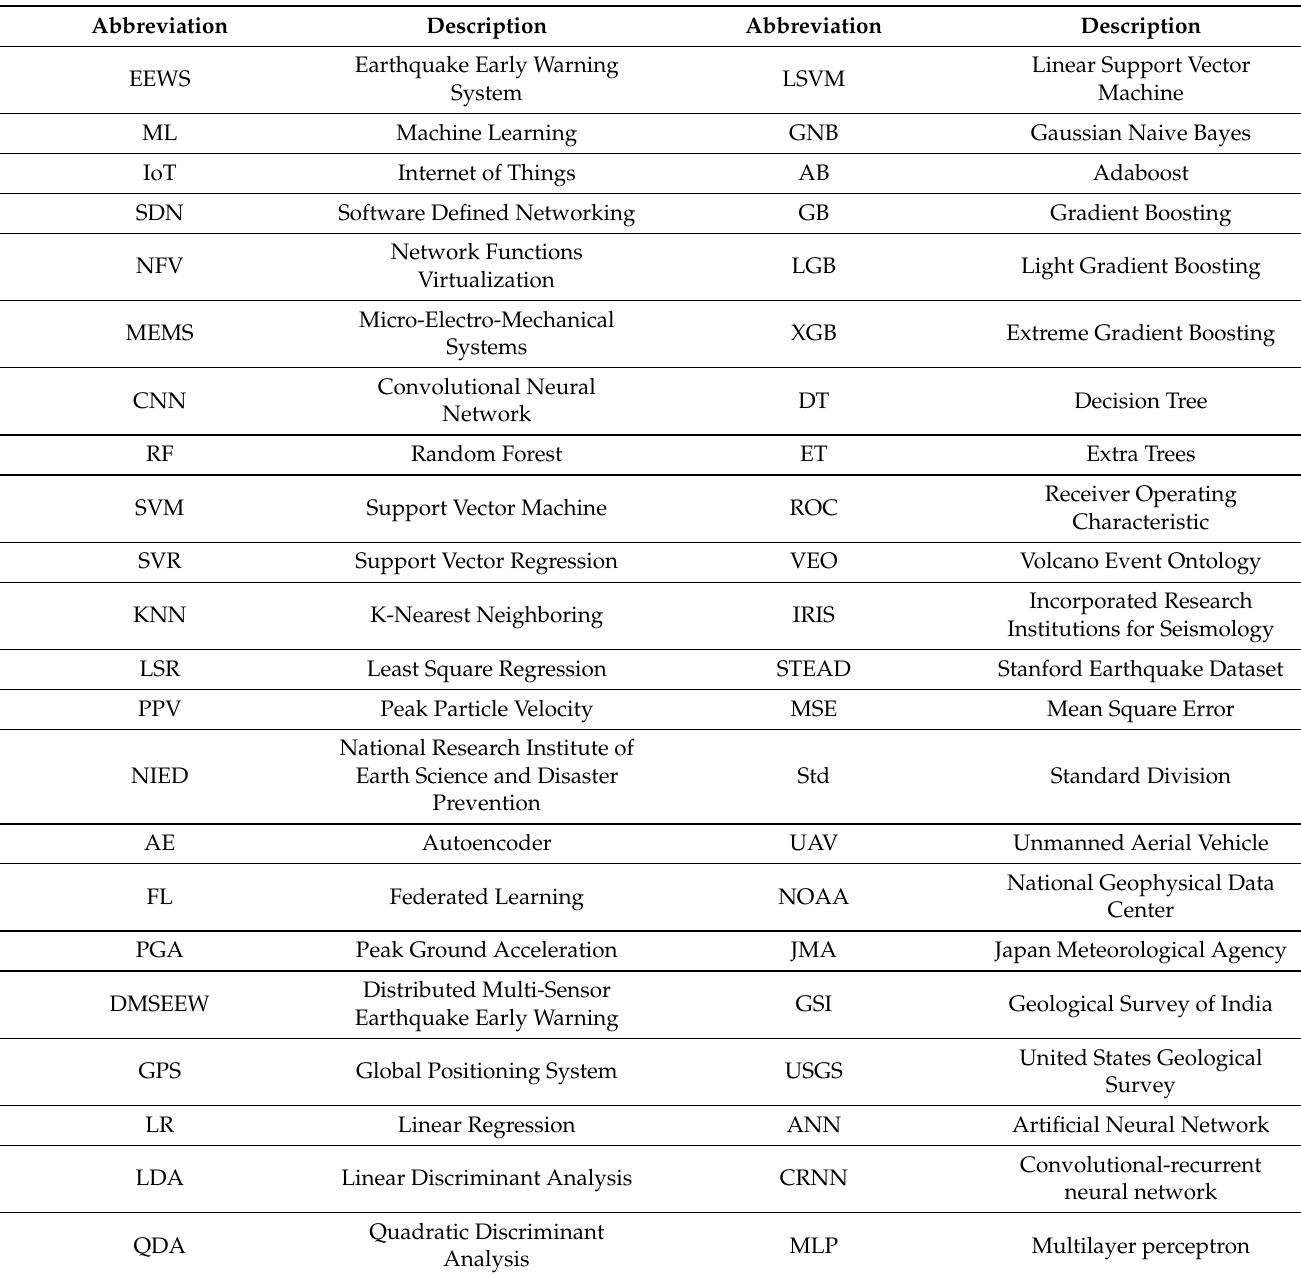
Table 1. List of